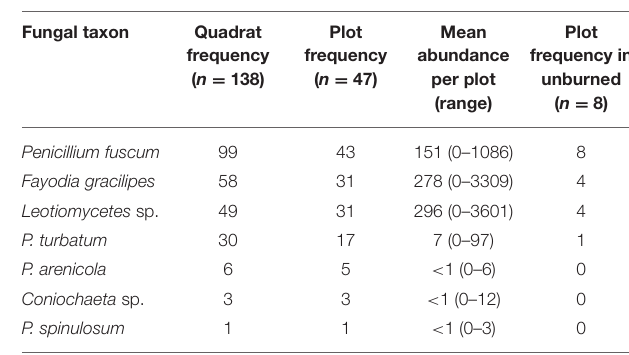
Frequency across 138 quadrats in 47 plots, and the mean and range of the relative abundance (number of reads) per plot are shown. Information is based on matching Sanger sequences of the isolated heat-resistant fungal taxa with operational taxonomic units from high throughput sequencing (Illumina, MiSeq) sequences at 47 plots at 97% similarity. Taxa are presented in declining order of plot frequency.